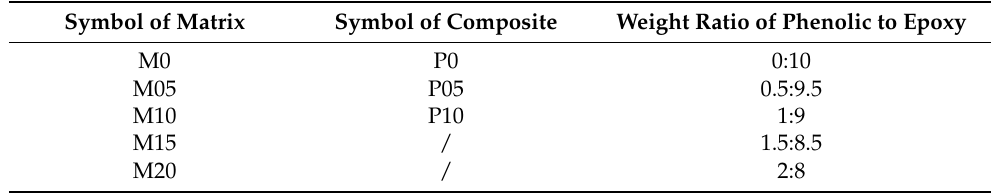
Table 1. Types of samples.